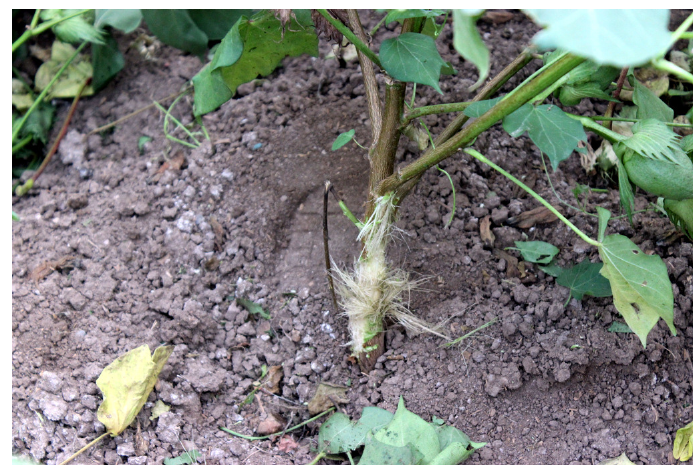
Figure 3. Results of mechanical girdling of field ‐ grown cotton plants utilizing a hand ‐ held motorized flap ‐ brush.